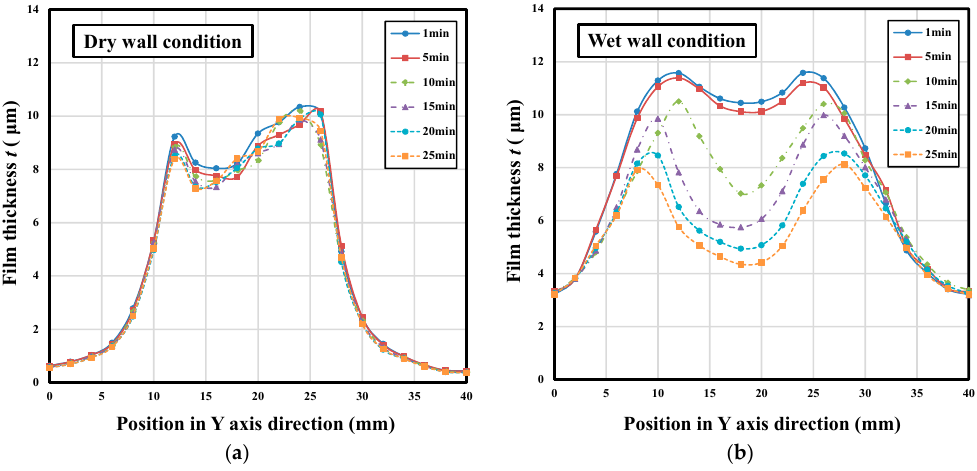
Figure 4. Variations of film thickness over time of: ( a ) dry wall conditions; and ( b ) wet wall conditions.